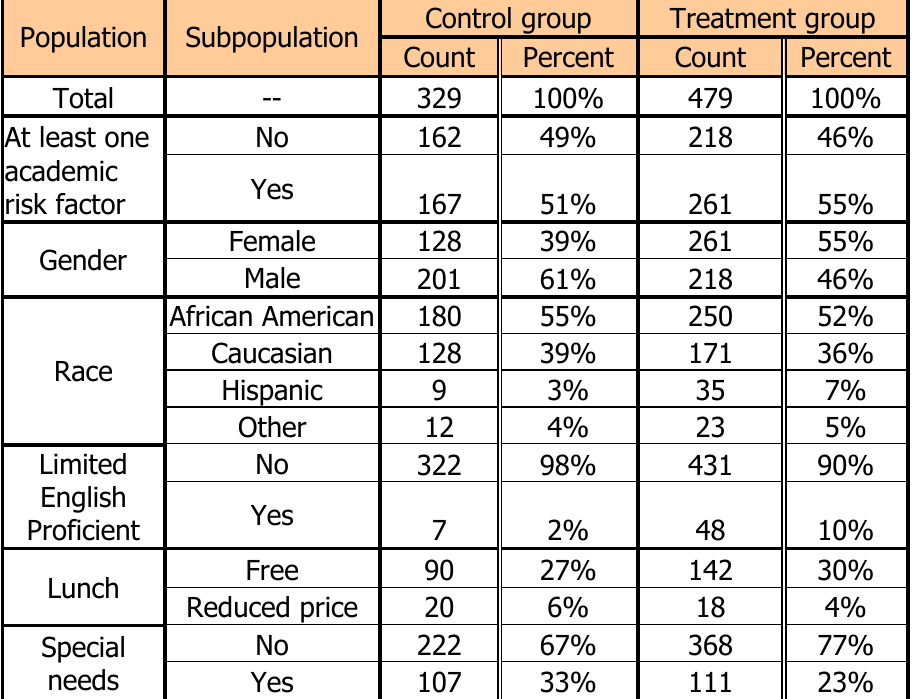
Comparison of Control and Treatment Group